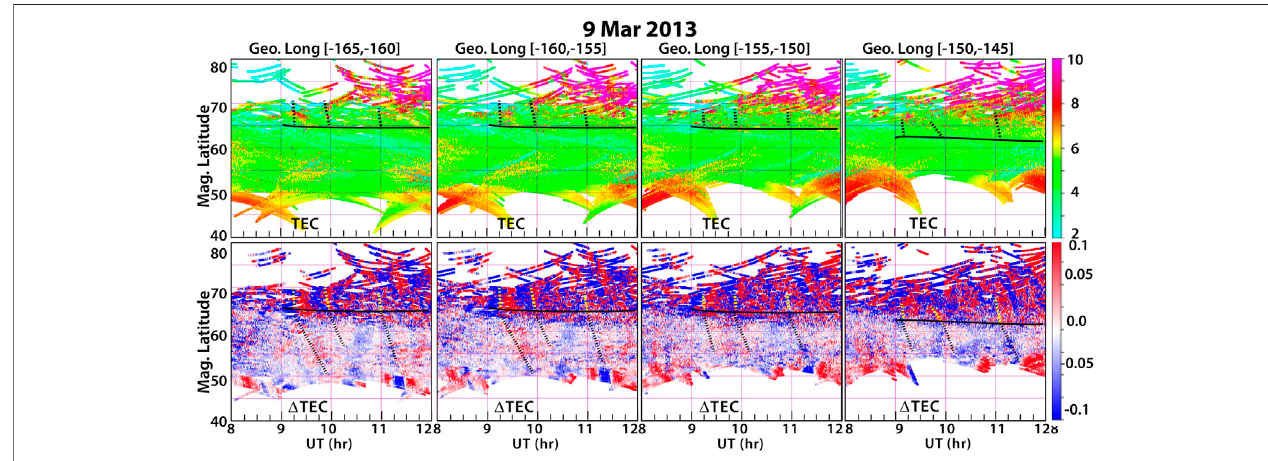
FIGURE12| AverageTECand Δ TECover5 ° geographiclongitudeincrementsfromwestof,tonear,PokerFlatonMarch9,2013,inthesameformatas Figure4 .